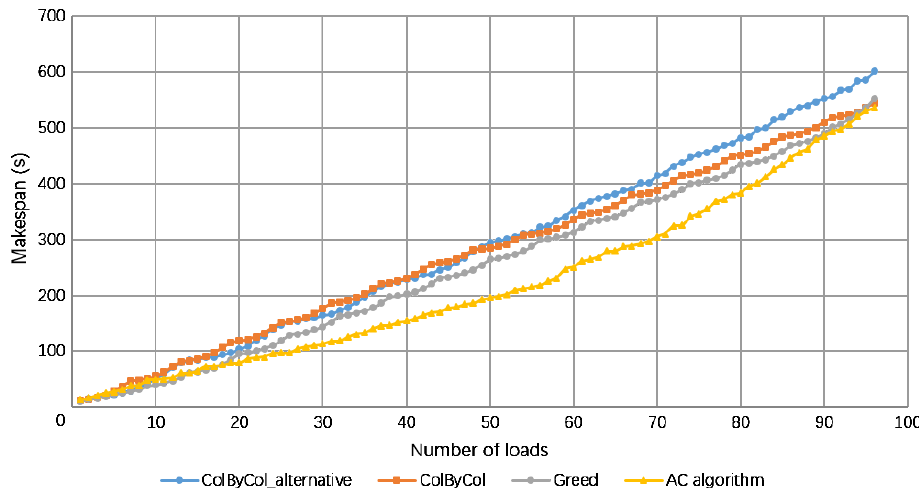
Fig. 12 Makespan of empirical rules, greed rule, and AC algorithm under six tiers and eight columns model.